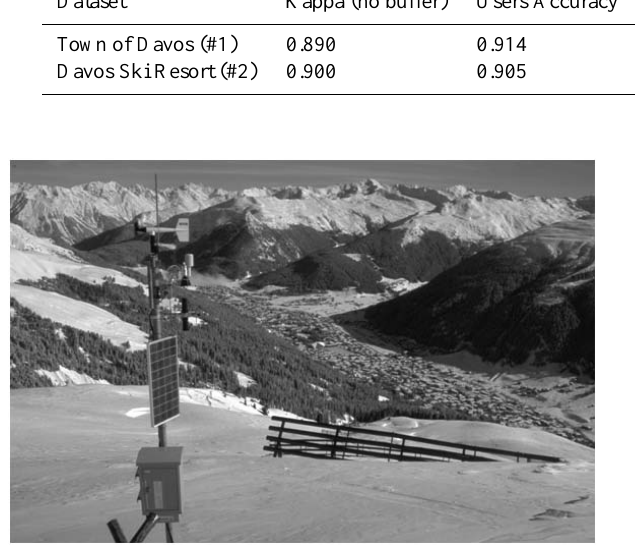
Fig. 6. View from Davos-Parsenn down to the town of Davos, Switzerland (Photo courtesy of: J¨urg Schweizer, SLF).